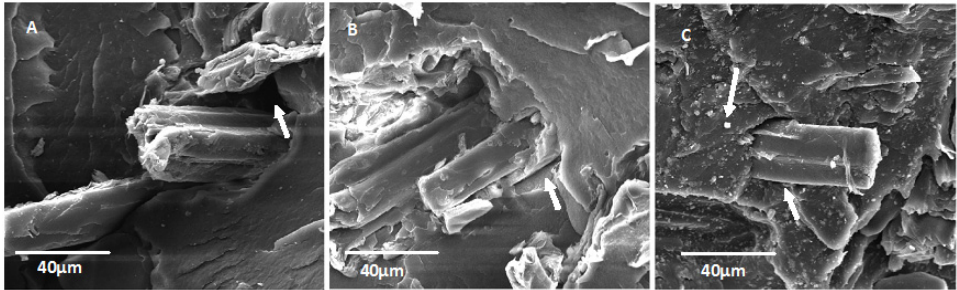
Figure 1. SEM of PP-SC ( A ), PP-SC-NaOH ( B ) and PP-SC-silane( C ).